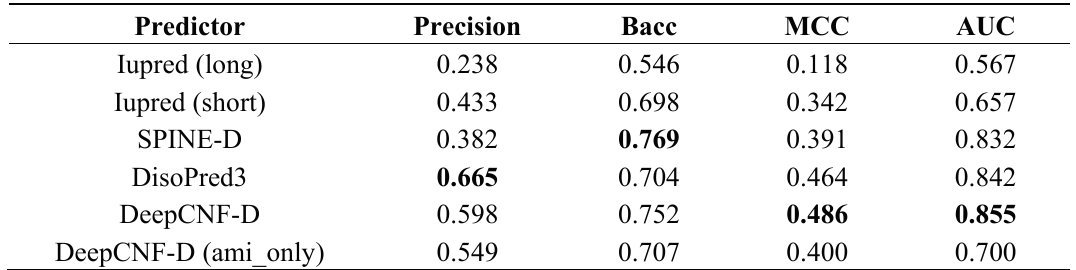
Table 6. Performance of several predictors on CASP9. We show average value for balanced accuracy (bacc), precision, Mattehews correlation coefficient (MCC), and Area under the ROC curve (AUC).